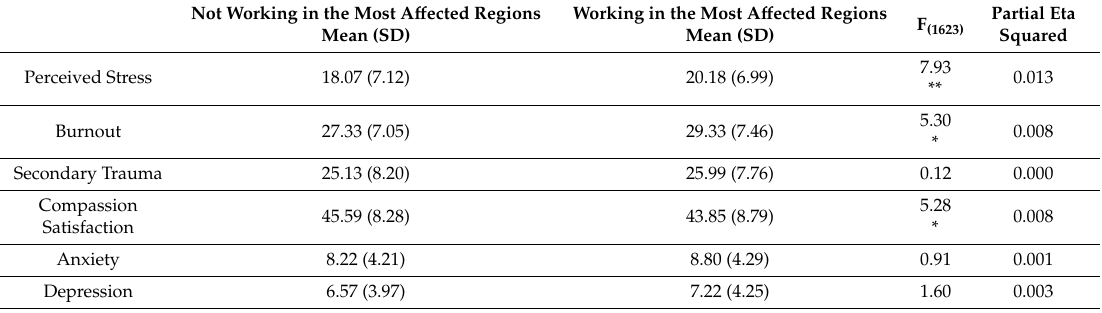
Table 3. Mean di ff erences between healthcare professionals working or not working in the most a ff ected Italian regions.